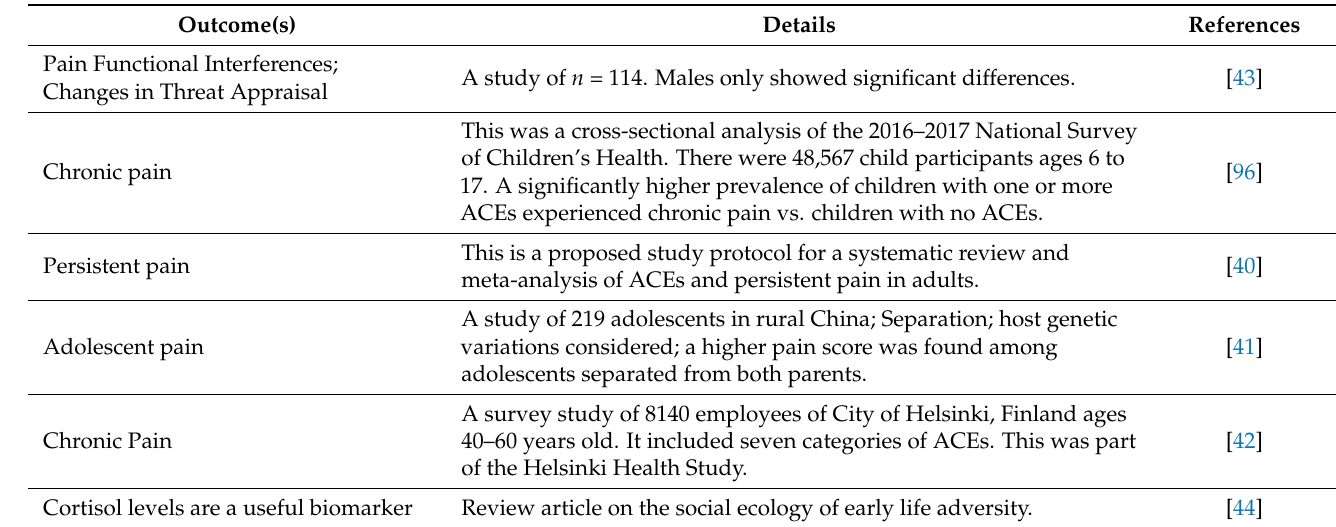
Table 3. Some Recent Examples of ACE Outcomes and Pain.